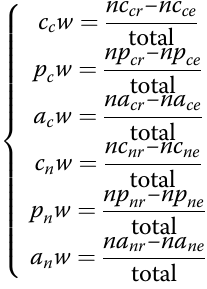
Figure 6 shows the classification of classification-normalized SVM. The obtained result is more accurate and the road region is completely recog- nized compared with Fig. 5. The error rate of the trained classifier is 6.79% and the positive sample is 6.79%. The testing time is between 0.003 and 0.006 s. Although the classification normalization loses some of the details of the image, it can retain the independence of each feature and weaken the interference among the three features caused by the fusion.